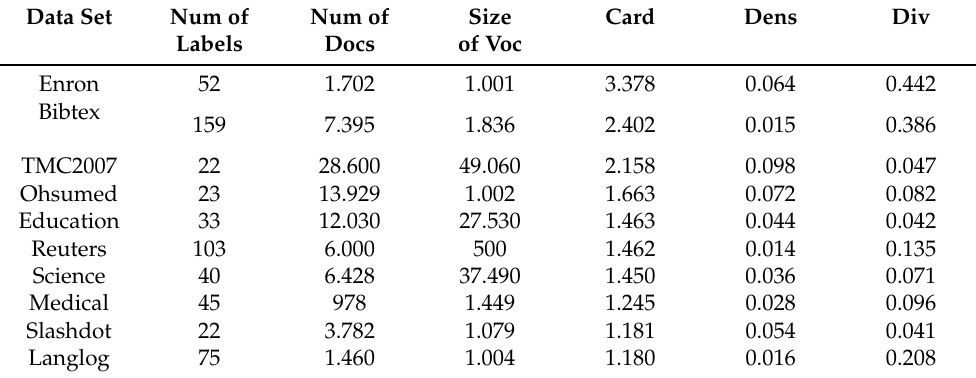
Table 5. Characteristics of the Preprocessed Data Set. Cardinality (Card) measures the average number of labels associated with each document. Density (Dens) is defined as the cardinality divided by the number of labels. The Diversity (Div) represents the percentage of label sets present in the set divided by the number of possible label sets. Vocabulary Size considers the volume of distinct